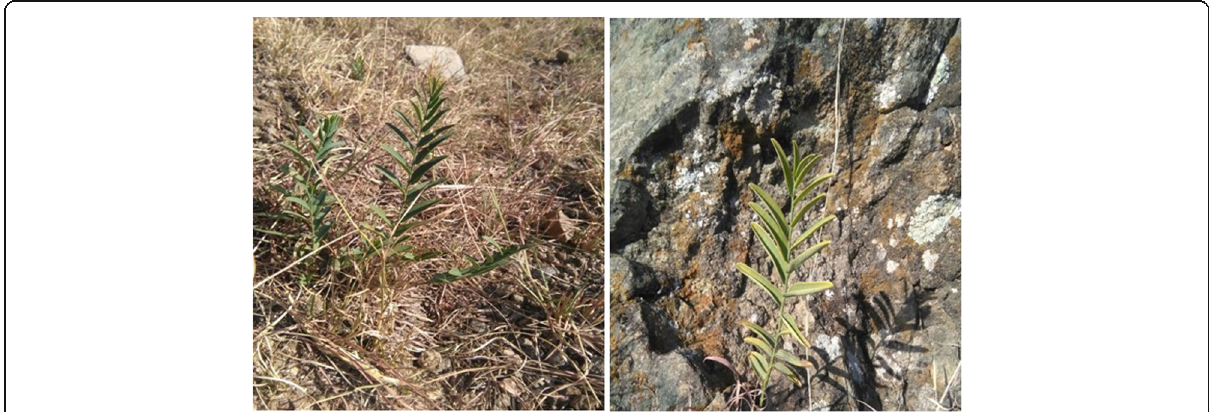
Fig. 1 Snapshot of Olax nana plant at collection point (Location: Swat district of Khyber Pakhtunkhwa,